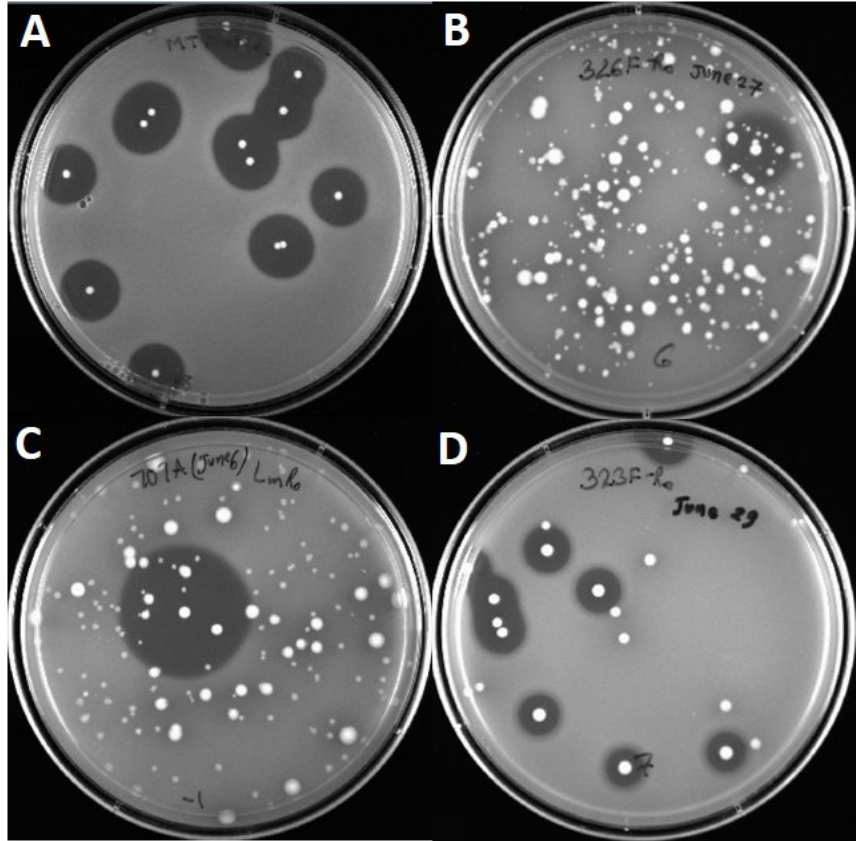
Figure 1. Inhibition of indicator lawns of L. monocytogenes 39-2 (R0) by various Bac + Enterococcus spp. from platings of food or animal-related samples after enrichment. Panel A, E. thailandicus FS92; Panel B, E. faecium 326F; Panel C, E. durans FS707A; Panel D, E. hirae